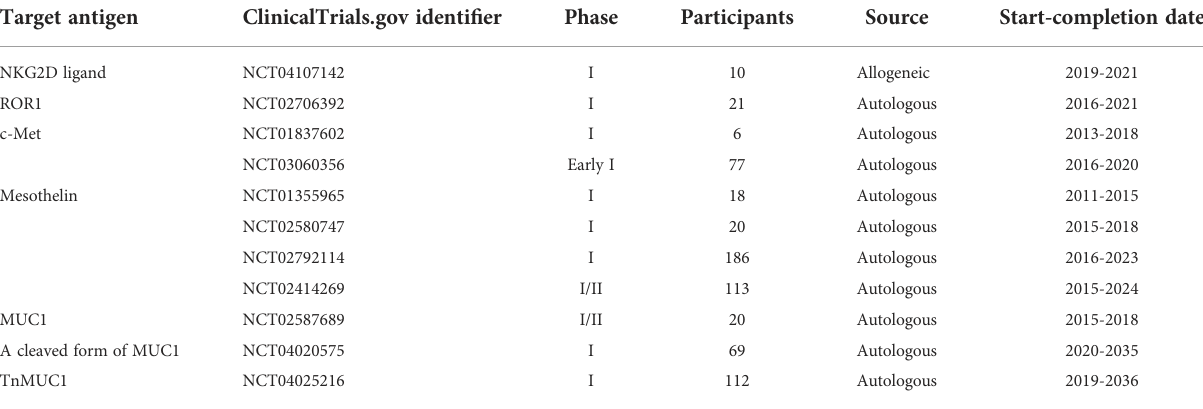
TABLE 3 A summary of different clinical trials investigating CAR-Ts against different target antigens for the treatment of TNBC and other solid tumors. Target antigen ClinicalTrials.gov identi fi er